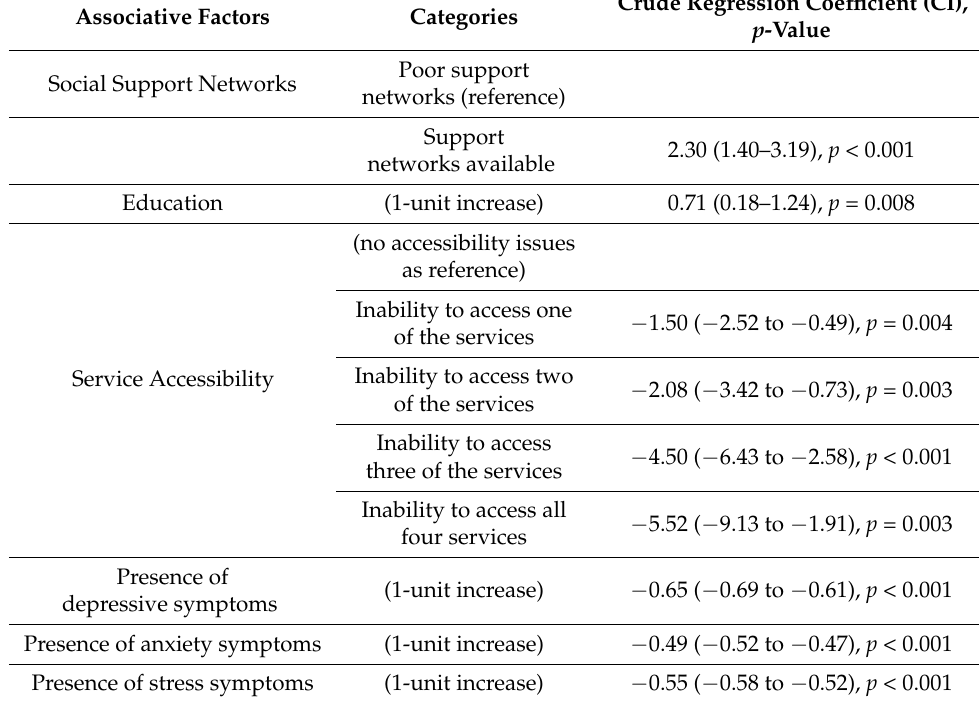
Table 4. Associative factors of well-being among people with disabilities. Associative